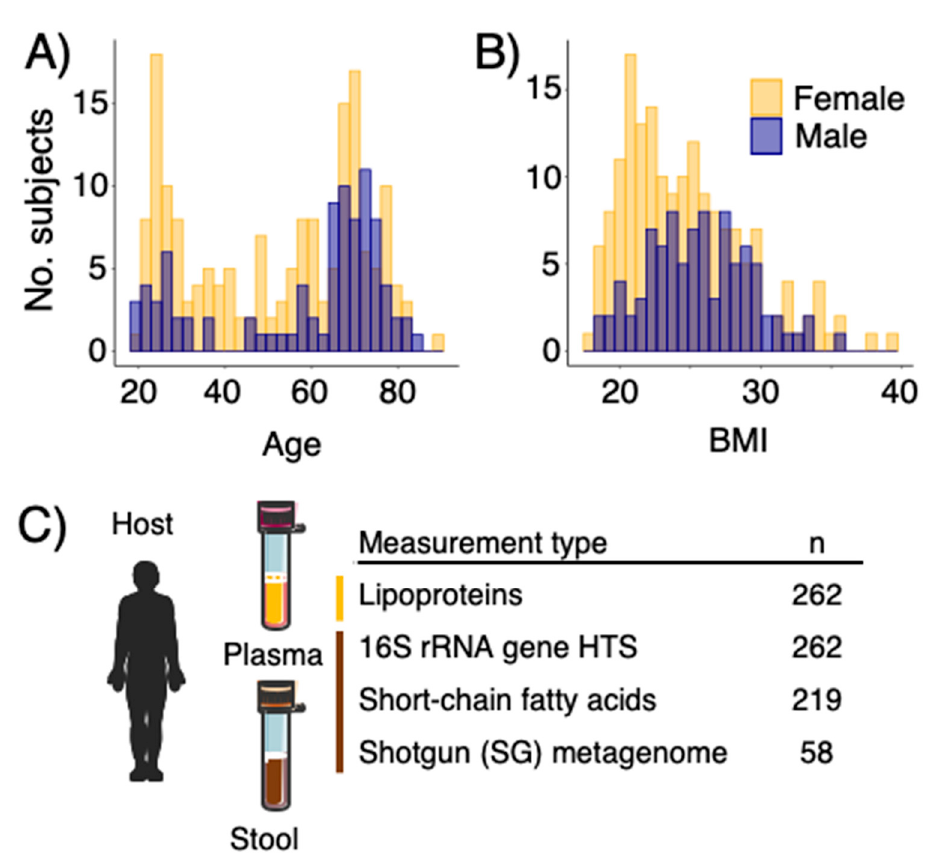
Figure 1. ( A ) Age and ( B ) body mass index (BMI) distribution of the study participants in COUN- TERSTRIKE. ( C ) samples and datasets included and analyzed in this